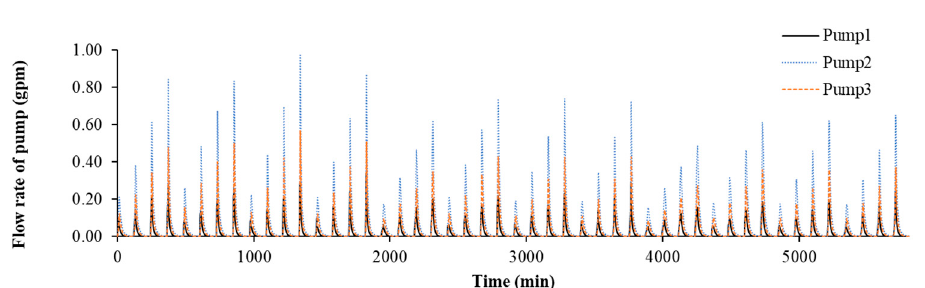
Figure 6. Generated time series of rainfall.